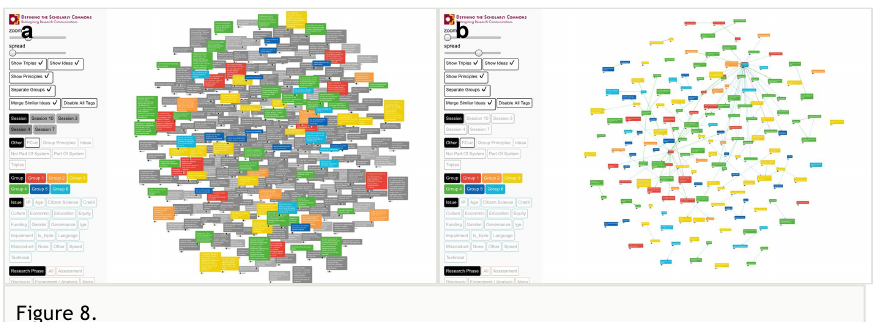
Figure 8. Workshop visualization - collection of ideas and group visions a : Visualization showing all ideas generated collectively in the fi rst round (session 3, dark grey) or second round (session 4, light grey), and those generated by the respective groups (solid colors) as part of their vision of scholarly communication. b : Visualizaton showing all groups' visions as interconnected elements (triples), with common elements overlapping.